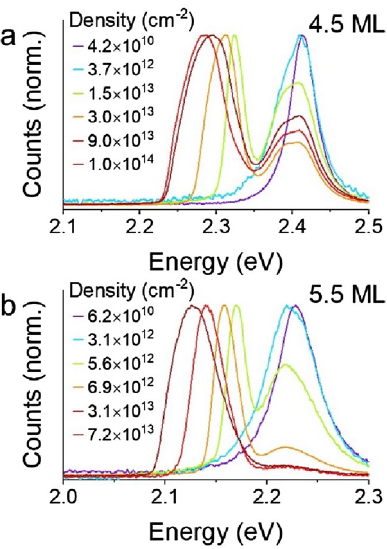
Figure 5. ( a , b ) High-fluence photoemission from a circular spot of ( a ) 9.8 nm × 15.4 nm 4.5 ML and ( b ) 9.0 nm × 26.8 nm 5.5 ML CdSe CQWs.